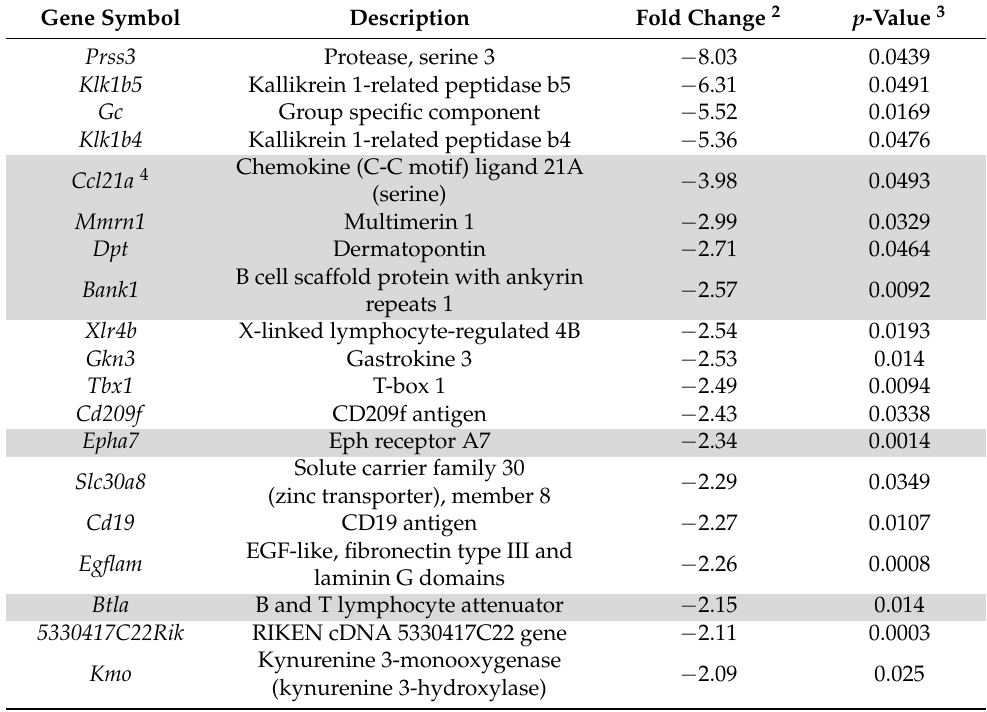
Table 2. Profile of downregulated genes in pancreatic tumors of mice treated with fucoxanthin (Fx) 1 . Gene